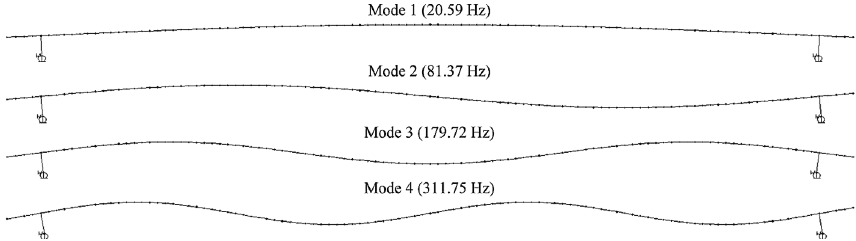
Fig. 10. Natural frequencies and vibration shape mode results of the analysis no. 2 (FEM), for the first four beam vibration modes